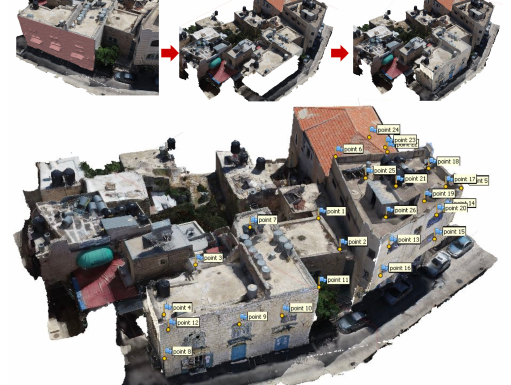
Figure 9: The Agisoft Photoscan visualization of chunks in which the cluster of Al-Anatreh neighborhood has been divided.